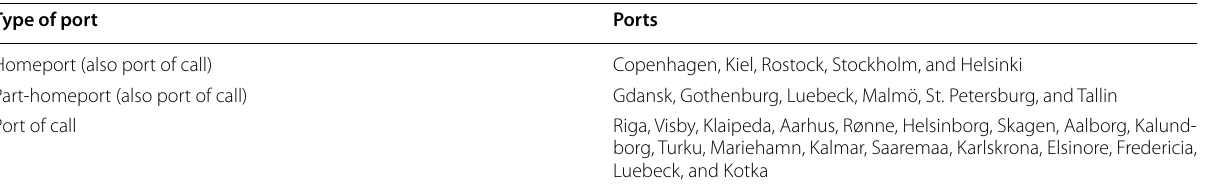
Table 2 Roles of Baltic ports analysed. Source : Author’s elaboration based on data from Cruise Baltic [39] Type of port